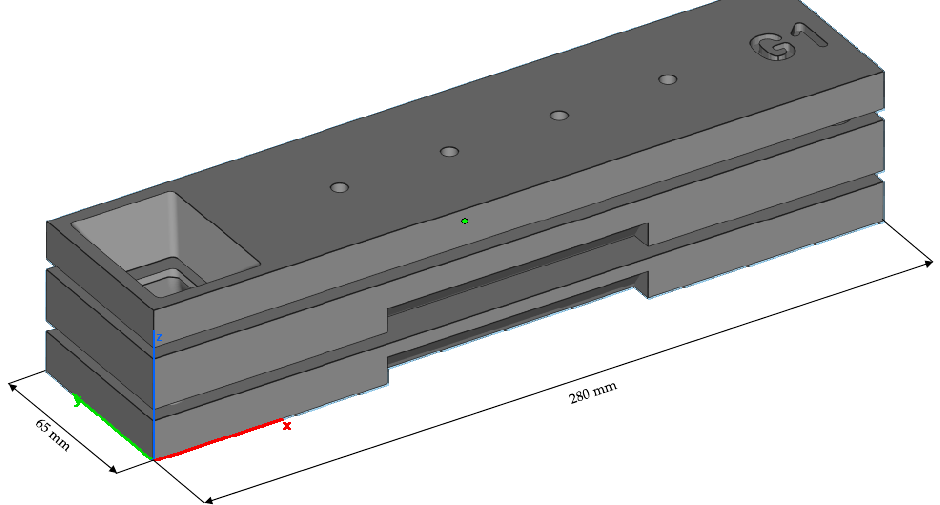
Figure 8. Schematic geometry of the three-part casting mold. The pouring basin is the hole on the left.